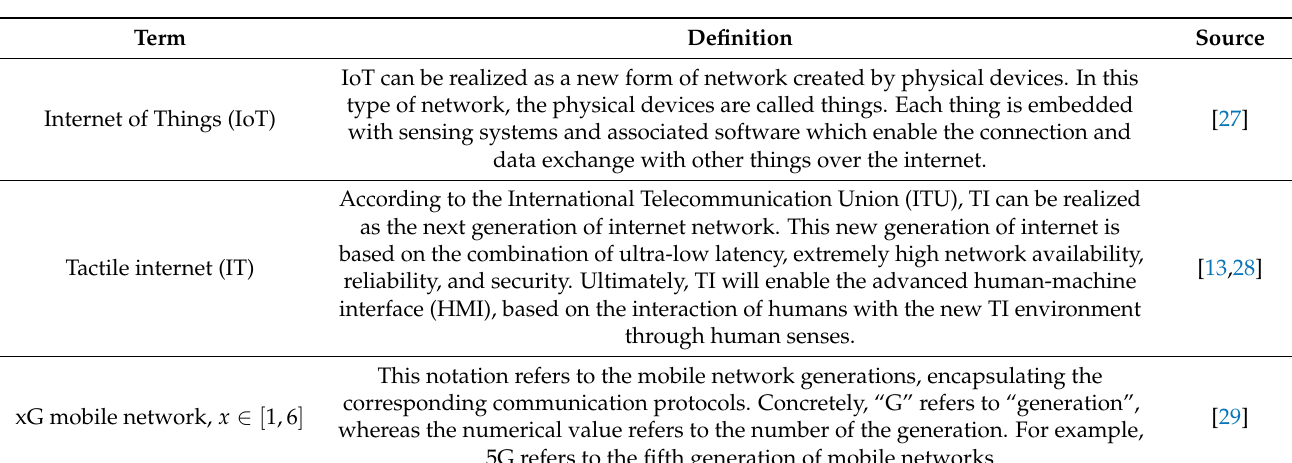
Figure 3. Verticals sectors’ capabilities and requirements spider charts [26]. Table 2. Glossary of Key